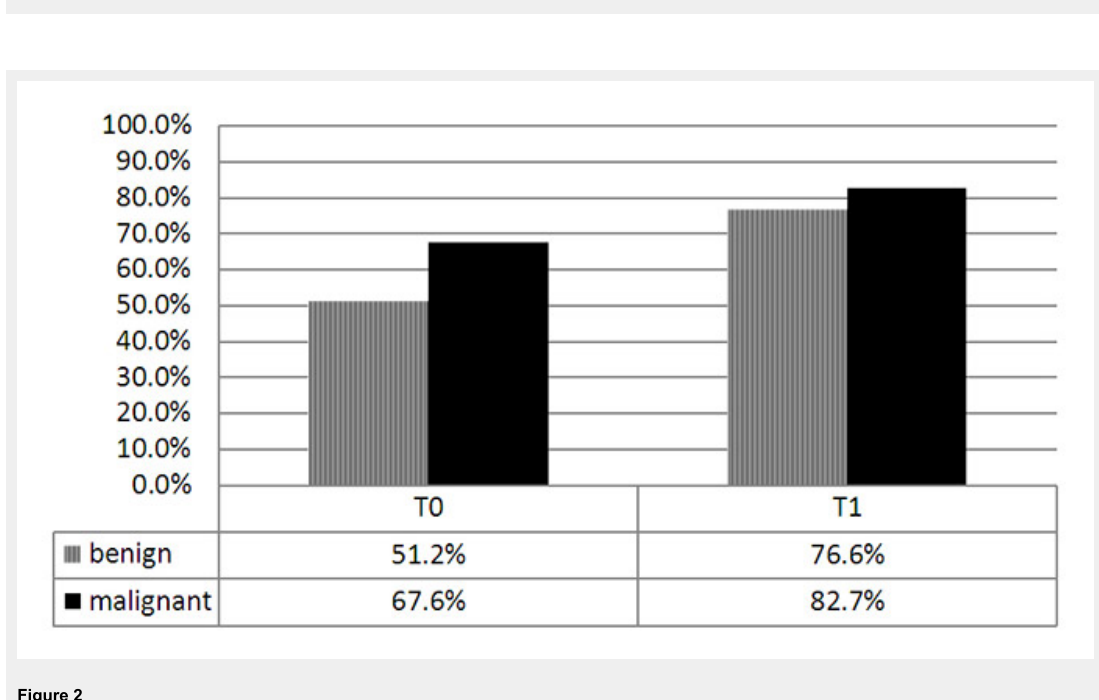
Figure 2 Percentage of correctly classified skin lesions before (T0) and after (T1) the one-day dermatologic education